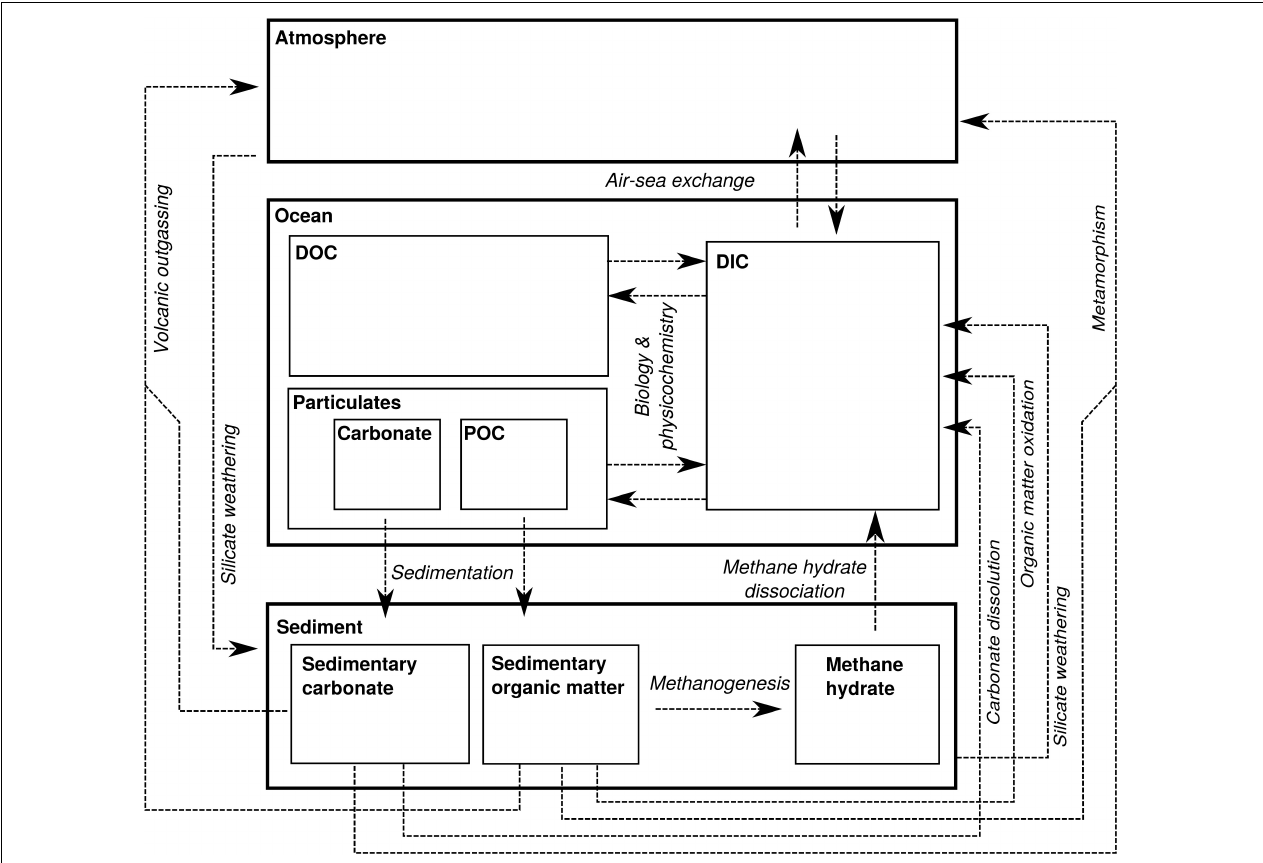
FIGURE 3 | Schematic representation of the biogeochemical carbon cycle with thick-lined boxes representing the major C reservoirs on Earth: the atmosphere, ocean and sedimentary record. The thin-lined boxes represent internal partitioning within these larger C reservoirs. F in is represented by metamorphism, volcanic outgassing and weathering (and episodically methane hydrate dissociation). The flux out of the atmosphere/ocean system is represented by OC burial ( F org ) and carbonate burial ( F carb ). Biology and physicochemistry is the sum of carbon fixation, OC remineralization, carbonate precipitation, and carbonate dissolution, which exchanges C between the ocean-internal dissolved inorganic carbon (DIC), dissolved organic carbon (DOC), particulate organic carbon (POC) and carbonate mineral